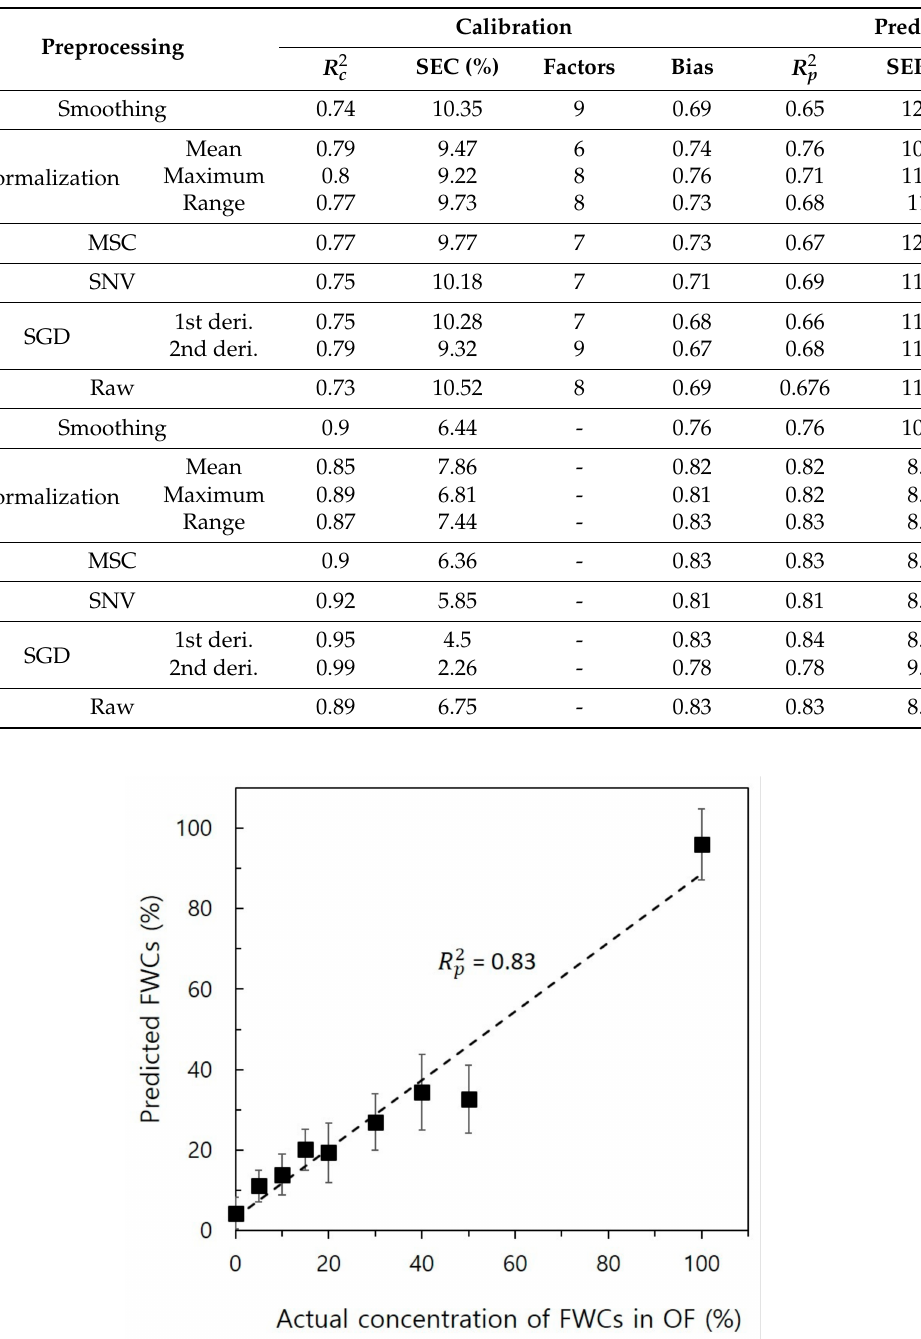
Figure 6. Correlation between actual and predicted FWC concentrations in mixture samples (0, 5, 10, 15, 20, 30, 40, 50, and 100%), for LS-SVM model with range normalization